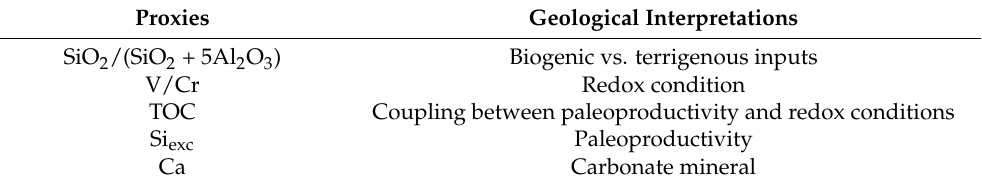
Table 2. Proxies employed for the chemostratigraphic purposes and their geological interpretations. Proxies